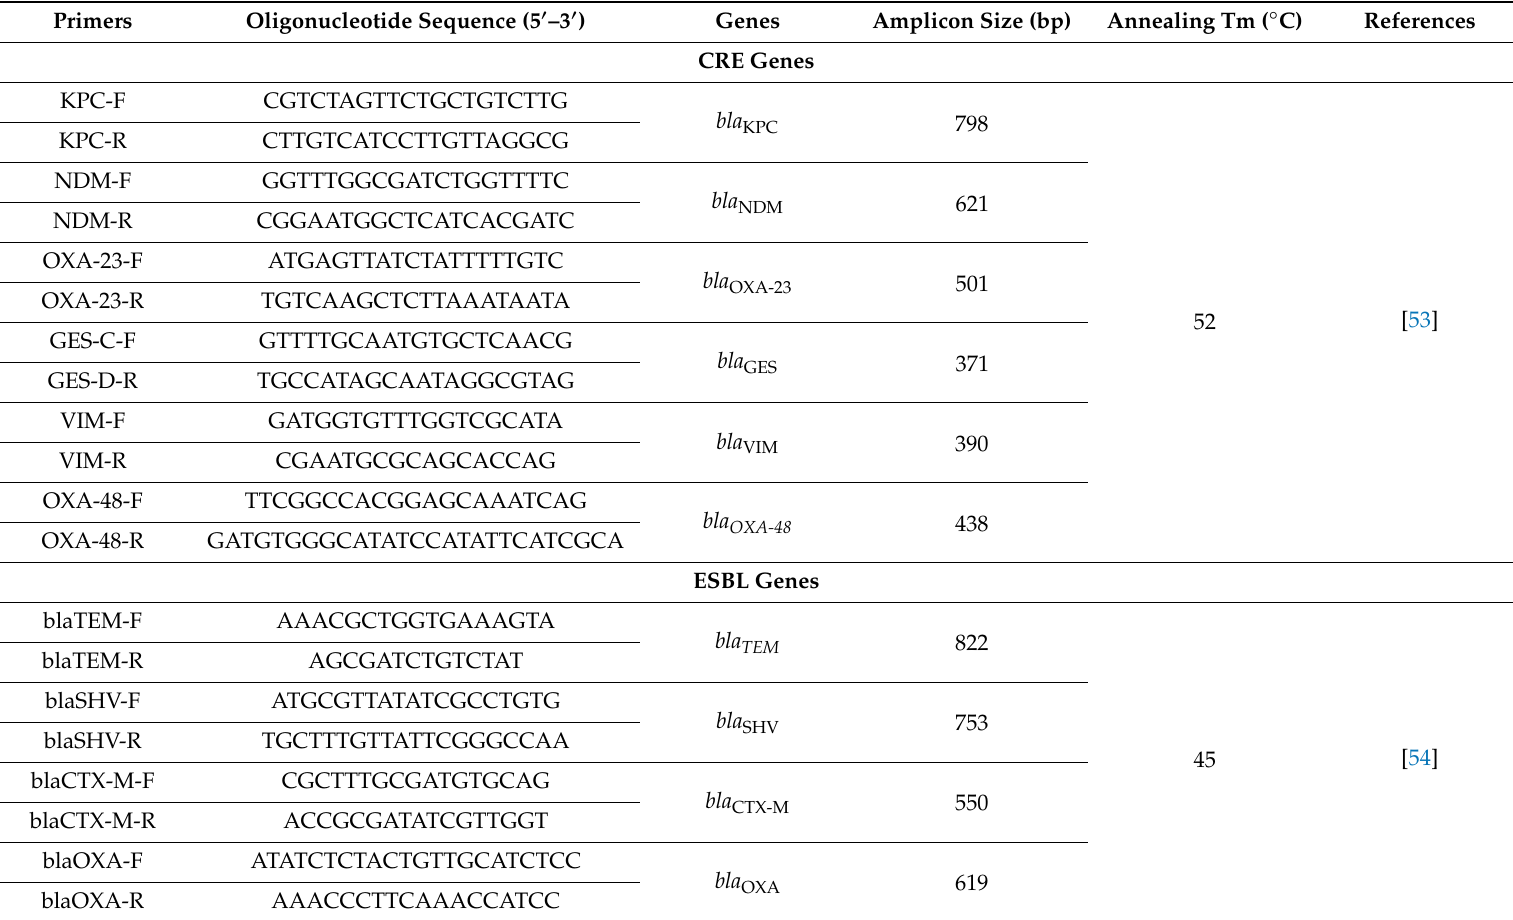
Table 4. List of oligonucleotide primer sequences and PCR conditions used in this